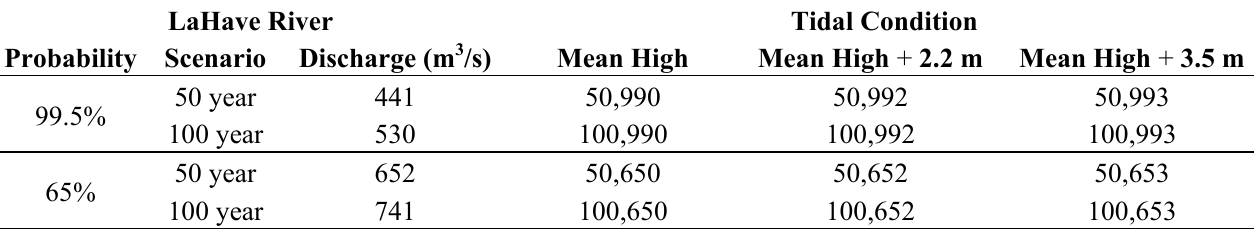
Table 4. Model simulations. The naming scheme of the simulations follows the format: the first 2–3 digits indicate a discharge return period of 50 or 100 years, the next 2 digits indicate the probability of occurrence being 65% or 99.5%, the last digits indicates the level of storm surge (0 for normal high tide conditions, 2 for a 2.2 m surge on top of the predicted tide or 3 for a 3.5 m surge on top of the predicted